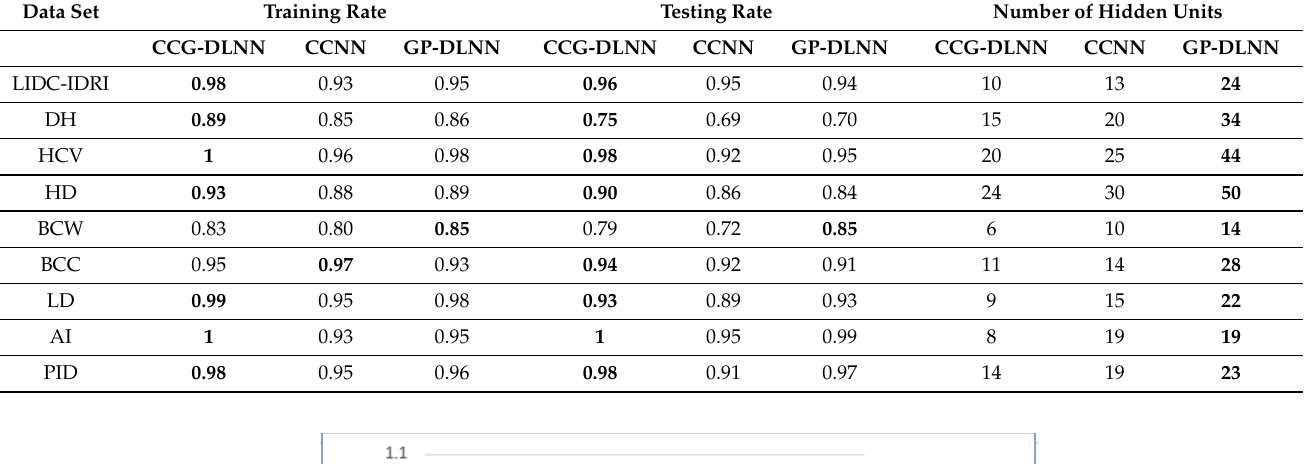
Table 4. Simulation results of CCG-DLNN, GP-DLNN and CCNN on real-world classification problems.